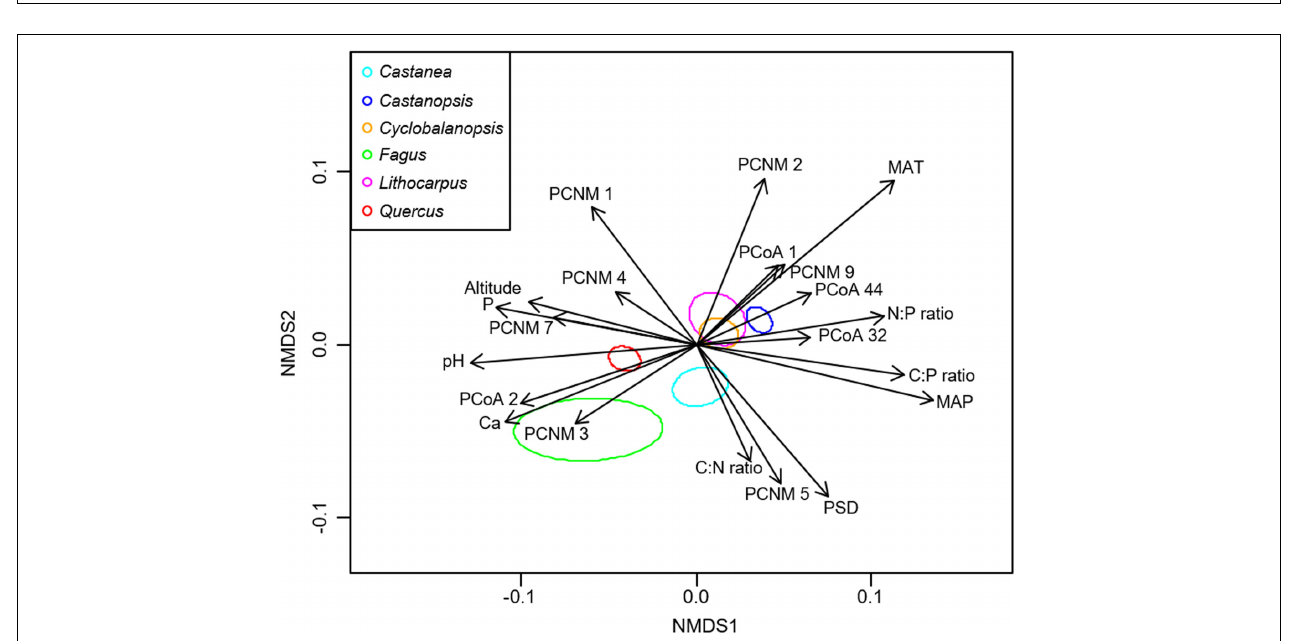
FIGURE 1 | Variation partitioning showing the pure and shared effects of plant, soil, climatic and spatial variables on ectomycorrhizal fungal richness. Numbers indicate the proportions of variation explained. C, total soil carbon; N, total soil nitrogen; P, total soil phosphorus; Ca, total soil calcium; PSD, particle size distribution; PCNM, principal coordinates of neighbor matrices. PCoA, principal coordinates analysis of host phylogeny; MAT, mean annual temperature; MAP, mean annual precipitation.